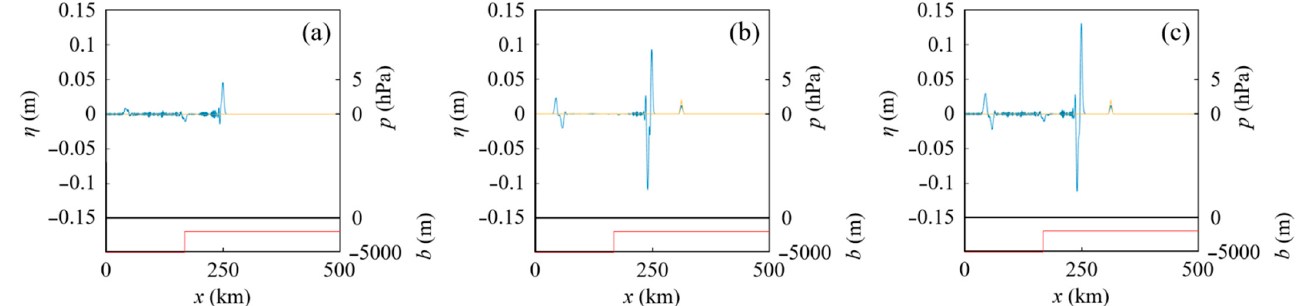
Figure 3. Water surface profiles at t = 1050 s in Case A, in which x 1 = 55 km in Figure 1; h on = 2000 m and x on = 170 km in Figure 2a. The blue, orange, and red lines indicate the water surface displacement η , atmospheric pressure p , and seabed position b , respectively. ( a ) The existing tsunami T Lamb propagated without the atmospheric pressure wave W 1 . ( b ) Tsunamis were generated by W 1 without T Lamb . ( c ) T Lamb was amplified by W 1